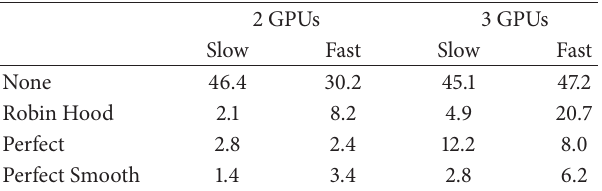
formula to determine the workload for worker 𝑤 for frame 𝑖 + 1 based on the unit count and render time of frame 𝑖